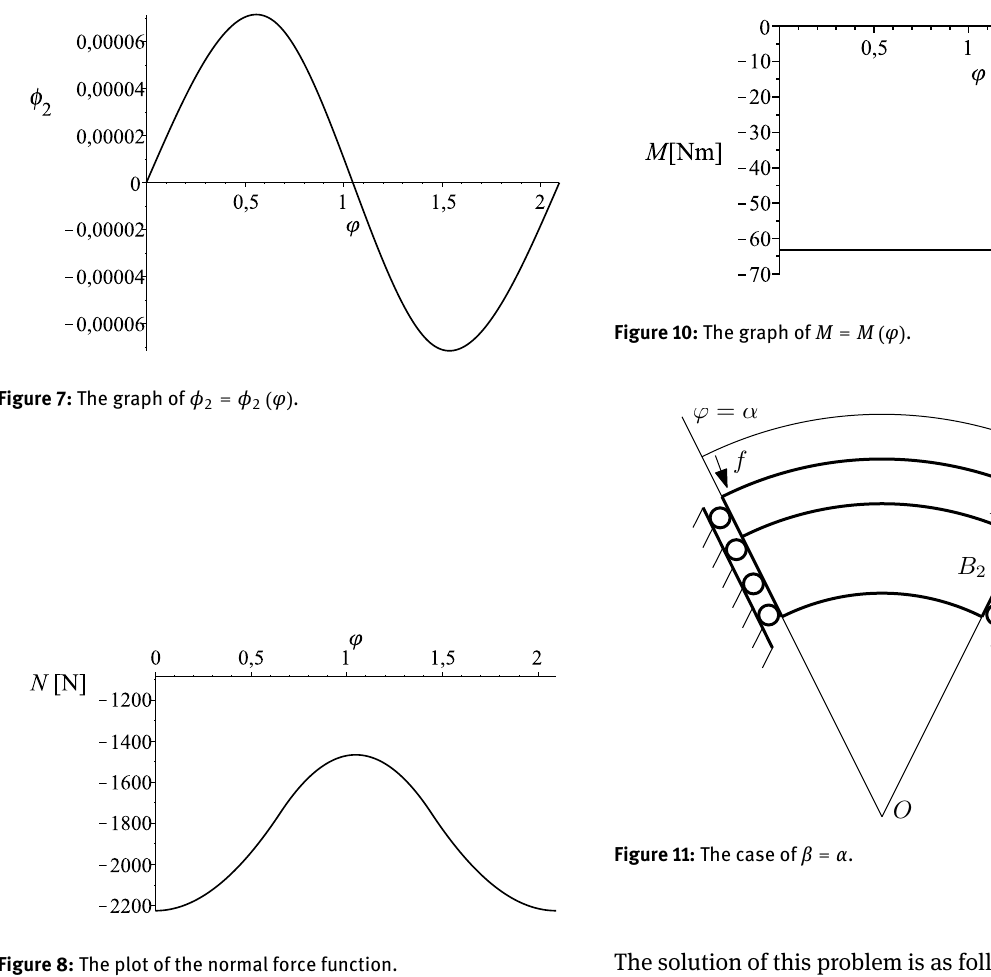
Figure 8: The plot of the normal force function.